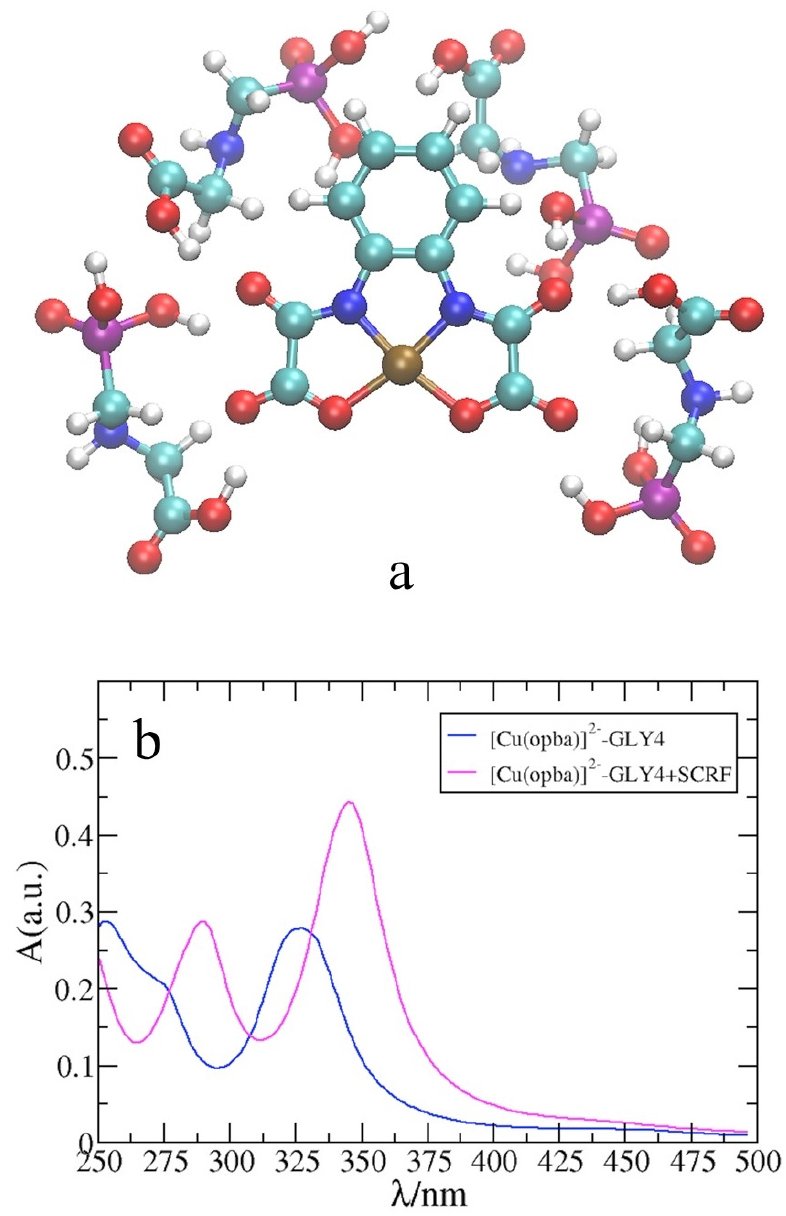
Figure 8. ( a ) B3LYP/SDD optimized structure of [Cu(opba)] 2 − (GLY) 4 . Atom colors: copper (brown); carbon (cyan); nitrogen (blue); oxygen (red); hydrogen (white); phosphorous (magenta). Some Some O . . . H(GLY) hydrogen bond distances (in Å) are: 1.66; 1.76; 1.78. ( b ) Absorption spectra from O…H(GLY) hydrogen bond distances (in Å ) are: 1.66; 1.76; 1.78. ( b ) Absorption spectra from MS MS (blue) and MS+SCRF (blue) and MS+SCRF (magenta).